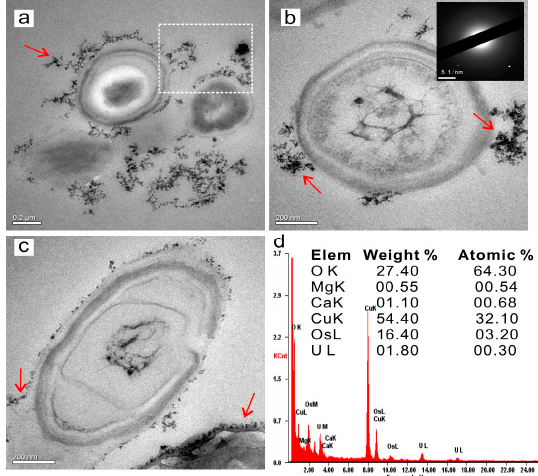
Figure 10. Weak crystalline minerals on the extracellular polymeric substances of SRB2. ( a – c ) Minerals on EPS of bacteria at Mg / Ca = 6, 10, and 12, respectively; the inset in ( b ) is the SAED image, showing the weak crystalline structure of the minerals on EPS; ( d ) EDS analysis of the selected